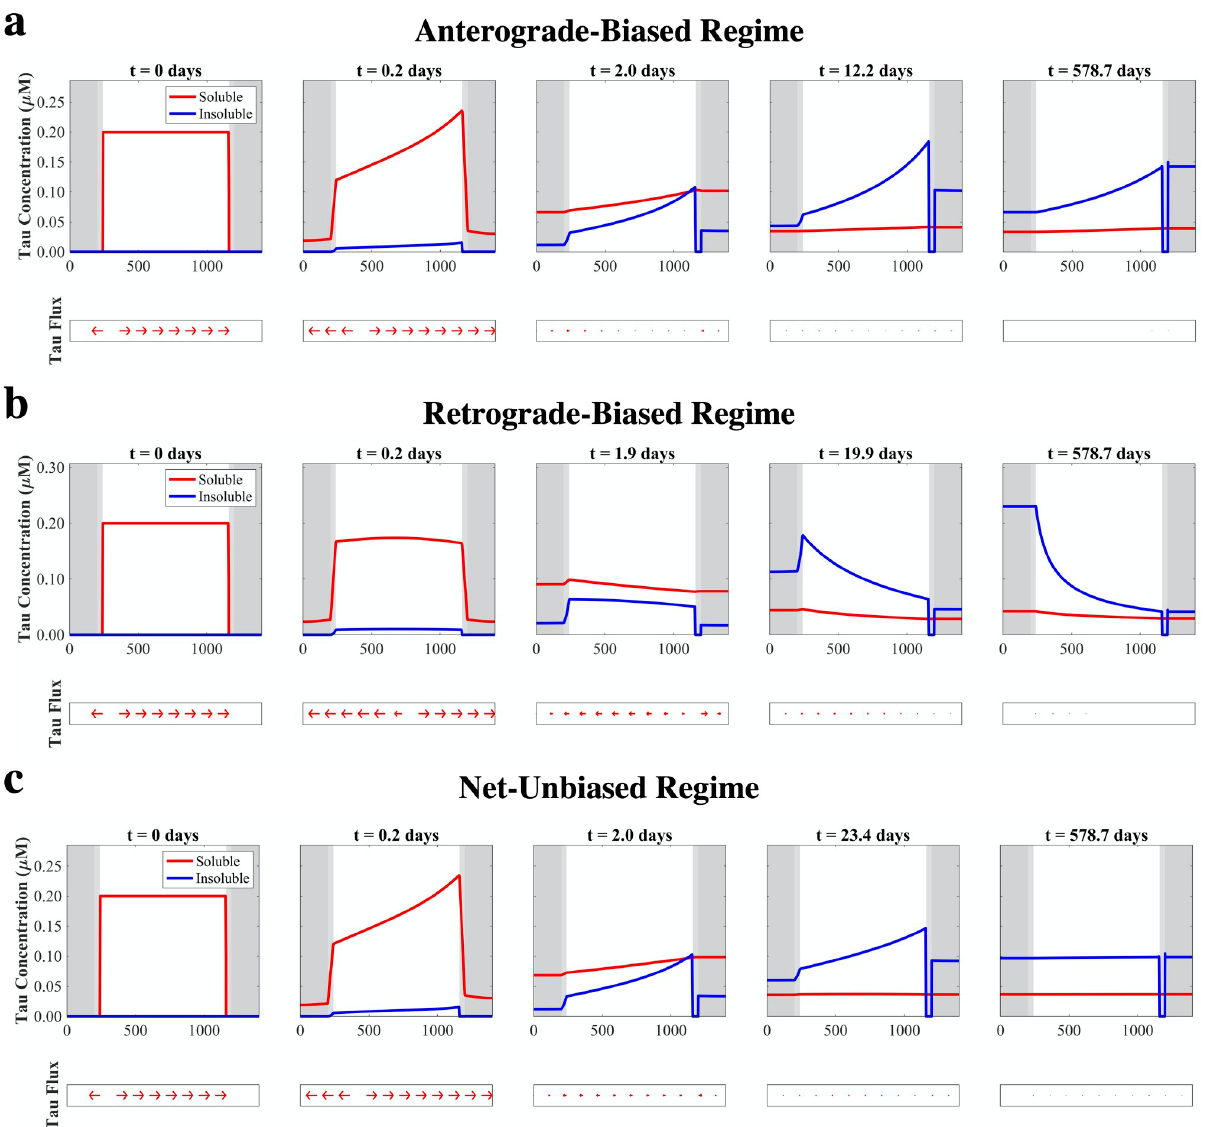
Fig 2. Model regimes are determined by tau transport feedback parameters δ and � . (a) Simulation results where δ = 1 and � = 0.01, which leads to a strong anterograde bias that emerges within hours and persists even at longer time scales. (b) Simulation results where δ = 0.01 and � = 1, which leads to a strong retrograde bias that only emerges at intermediate-to-late time scales. (c) Simulation results where δ = 1 and � = 0.35, which leads to an initial anterograde bias that is counteracted at intermediate time scales, leading to a uniform distribution of tau deposition at steady state.